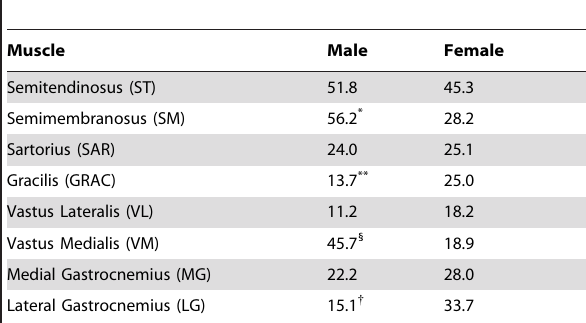
Table 4. Median values of fat fraction for the study cohort stratified by gender (19 males and 19